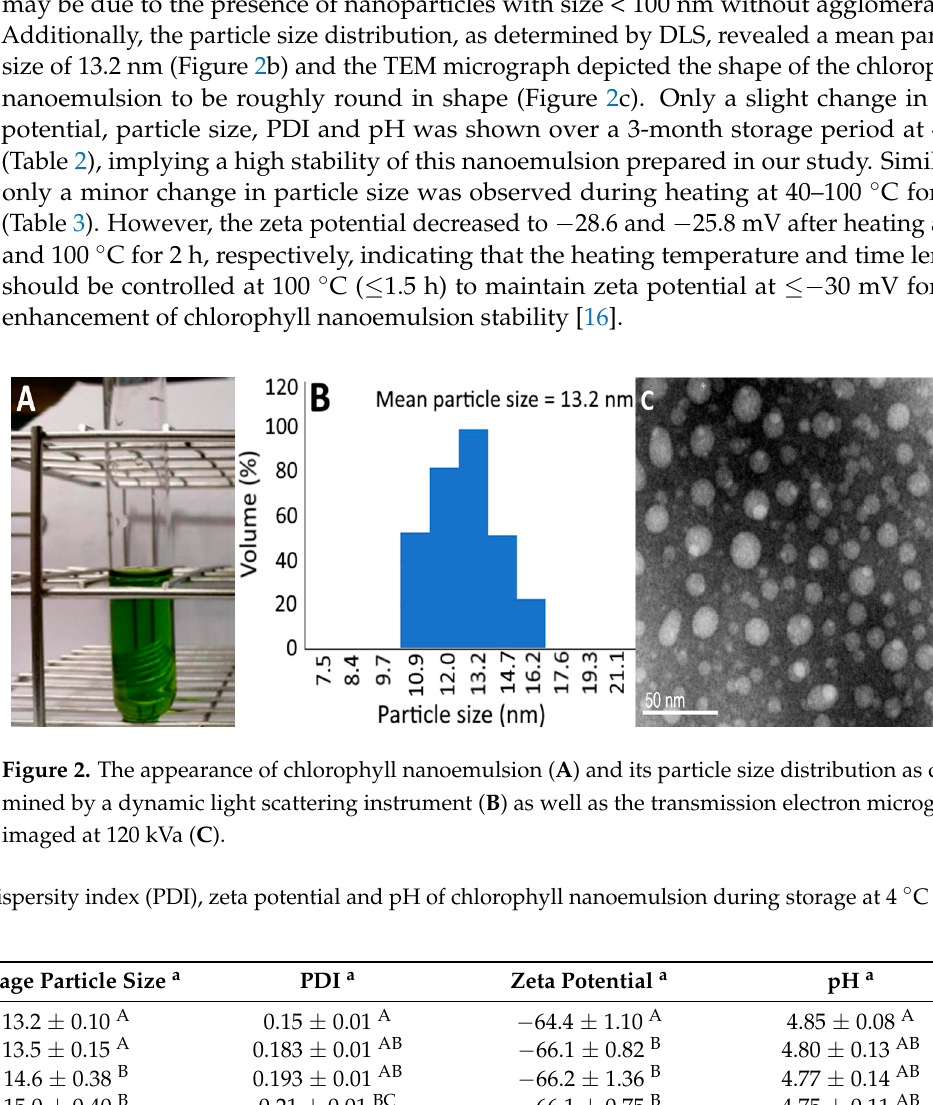
Table 1. Retention time (t R ), retention factor (k), separation factor ( α ) and contents ( µ g/g) of chlorophylls in Pomelo leaves.